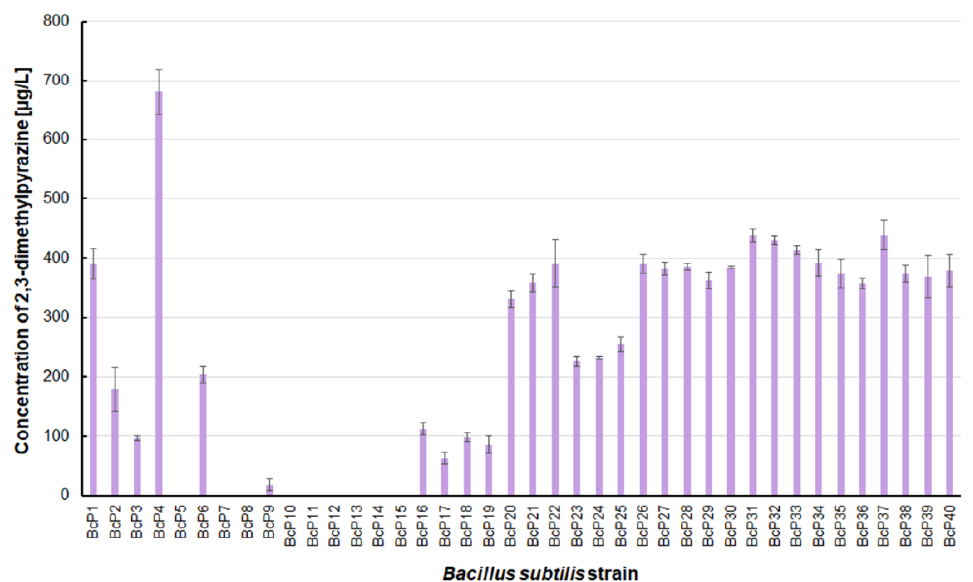
Figure 4. The 2,3-dimethylpyrazine biosynthesis by B. subtilis strains.